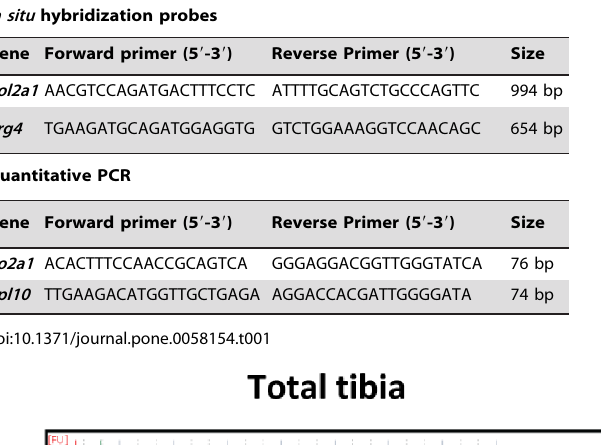
Table 1. PCR primers.